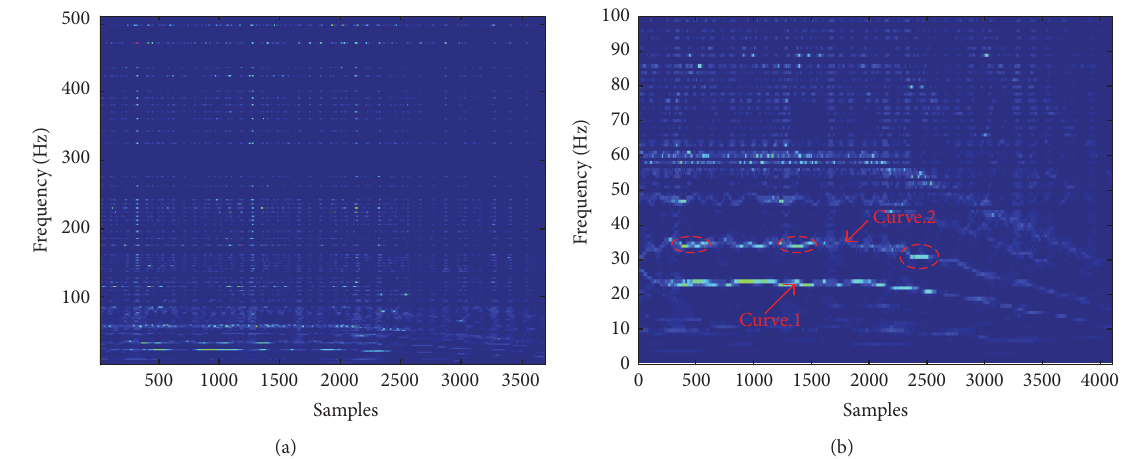
Figure 13: The time-frequency spectrum of the vibration signal shown in Figure 12(a). (a) The complete time-frequency spectrum; (b) the time-frequency spectrum in [0, 100 Hz ] .